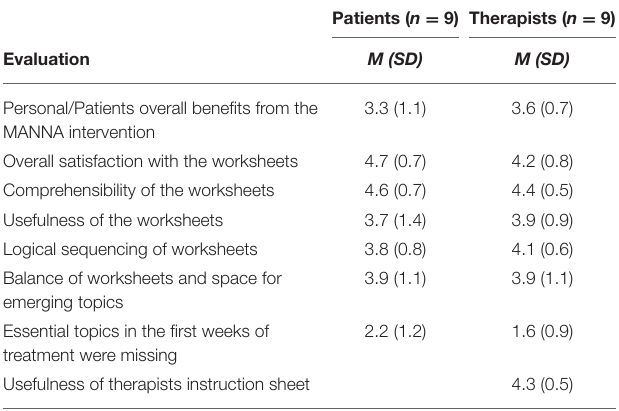
TABLE 2 | Evaluation of acceptance and feasibility of the MANNA intervention. TABLE 3 | Single comparisons between the study groups at week 5 (t1) and at